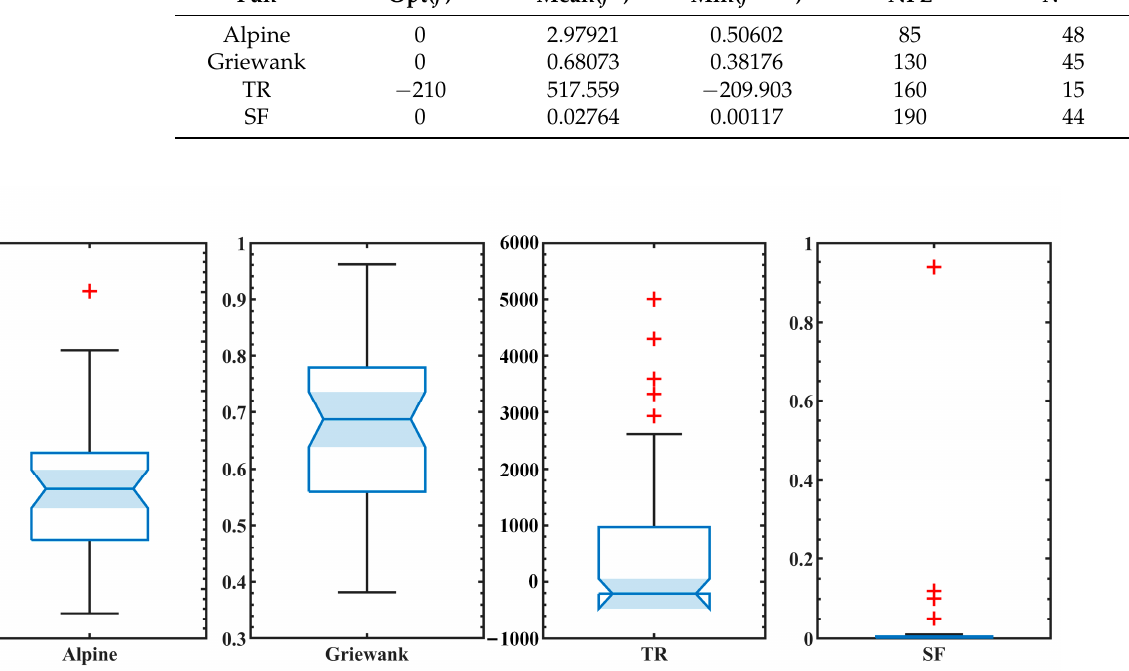
Figure 9. Results of the approximate global minima for four high dimensional problems.